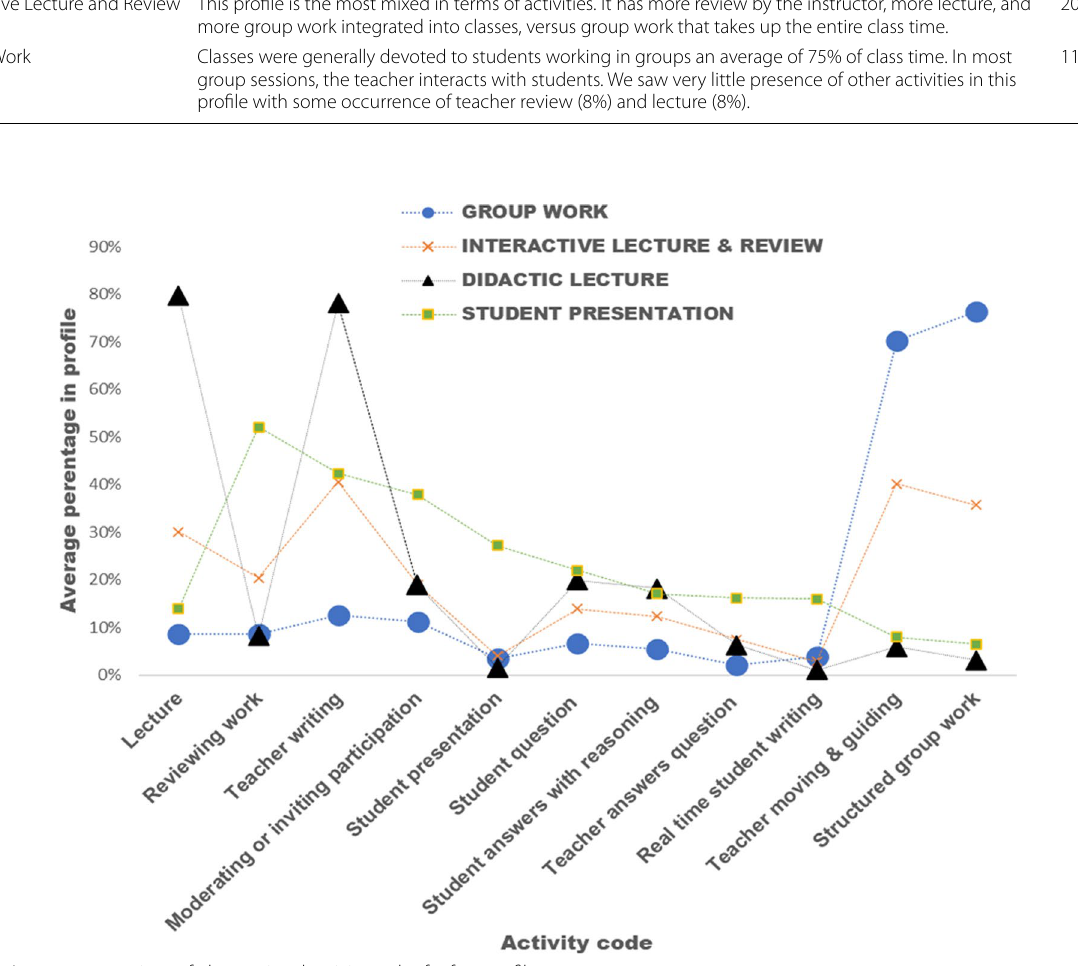
Fig. 1 Average proportions of observational activity codes for four